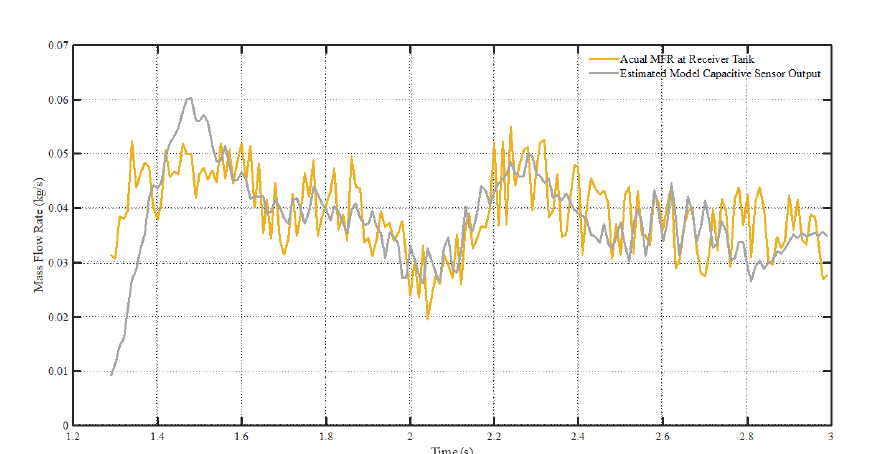
Figure 19. Actual MFR as a function of the MFR capacitive sensor.